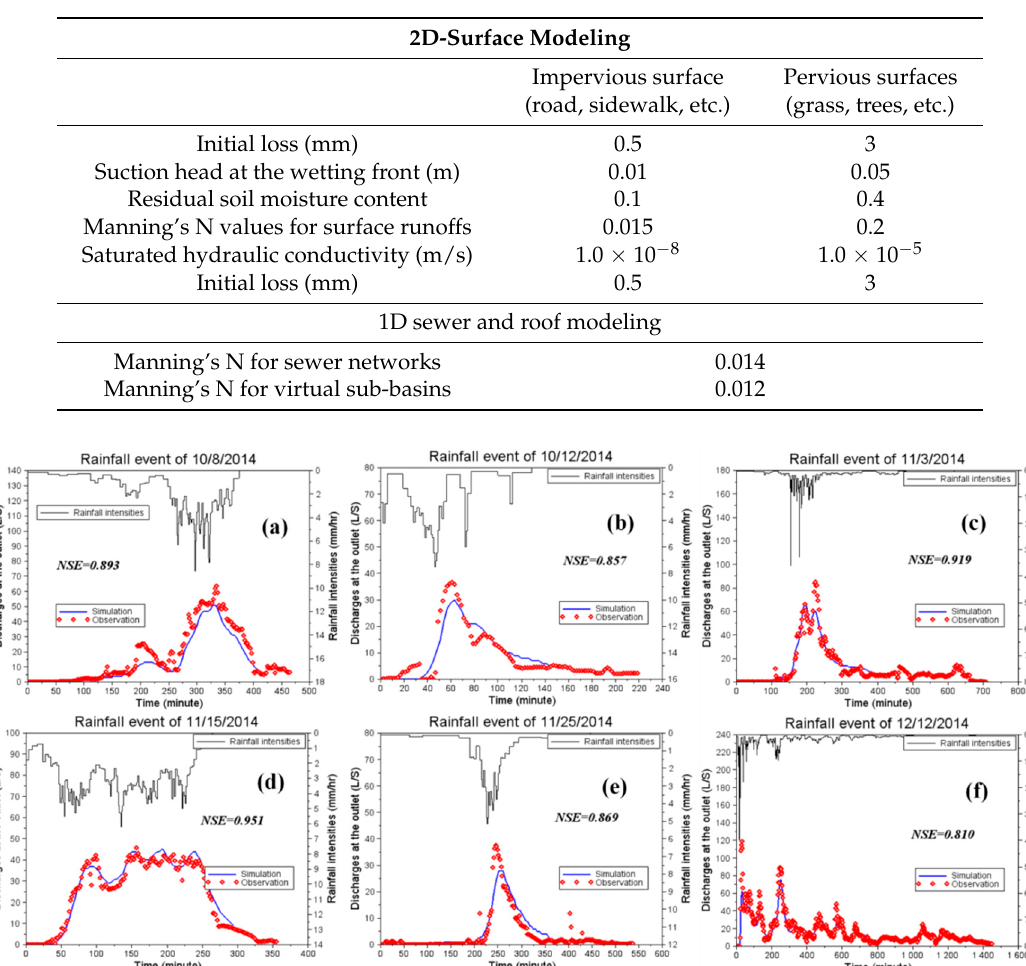
Table 2. Parameter values for the 2D-surface and 1D-sewer modeling.